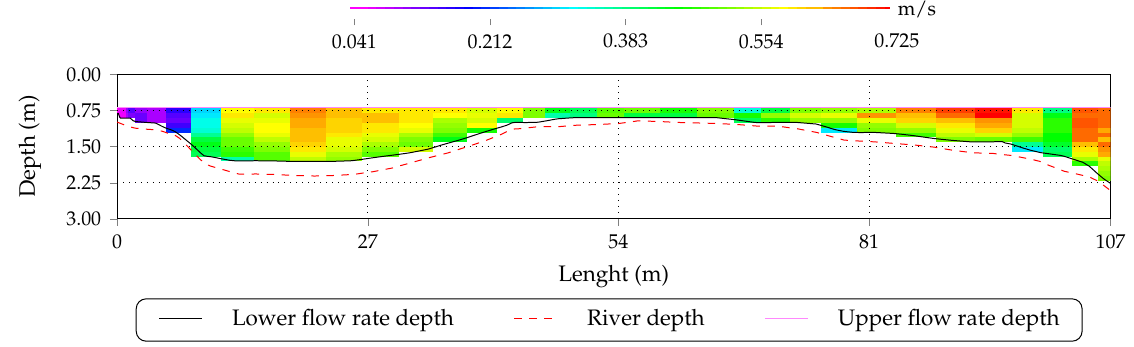
Figure 7. Magnitude of the flow velocity, referenced to the bathymetry (m/s).